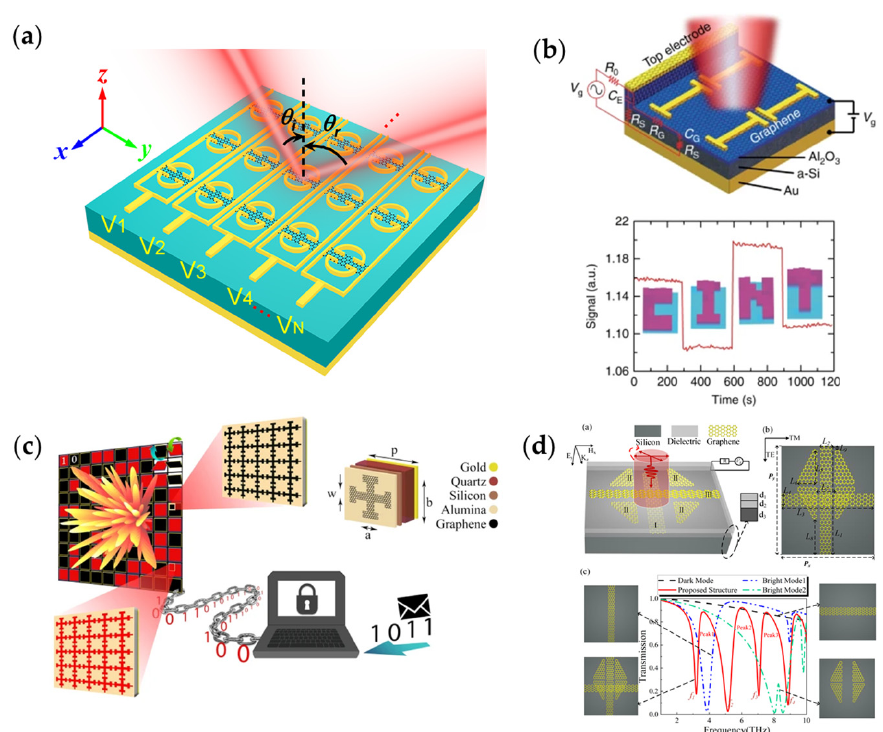
Figure 4. ( a ) Metasurface realizing dynamic 360° phase modulation with relatively high reflectance above 20%; ( b ) Amplitude-modulated graphene metasurface realizing specific near field imaging; ( c ) Graphene coding metasurface and a new encoding strategy based on the metasurface; ( d ) A multifunctional optical device based on graphene to realize optical switching and polarization splitting.